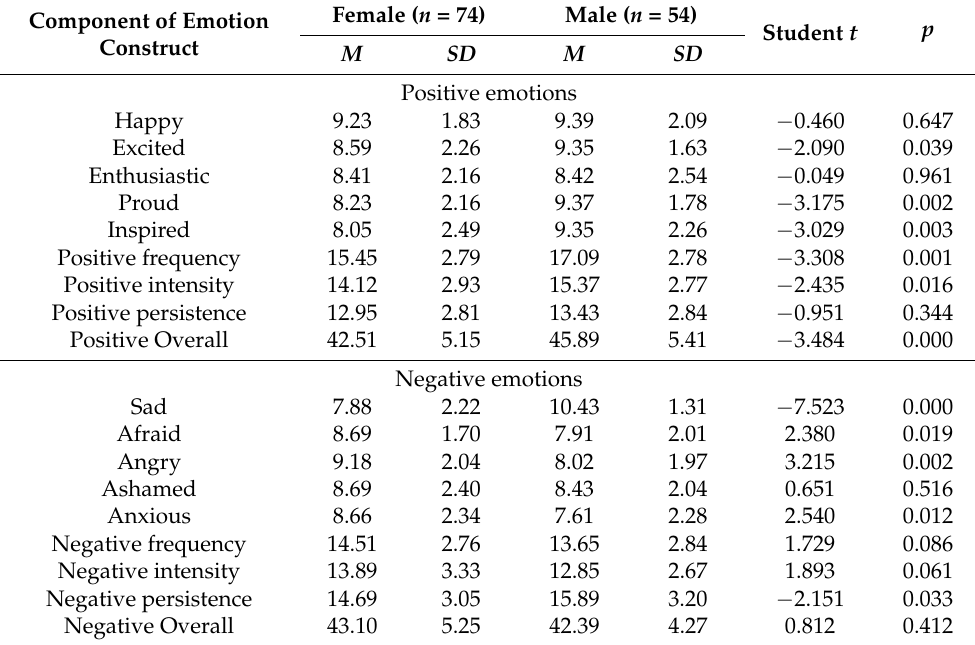
Table 3. Scores of the emotion variables in terms of gender *.